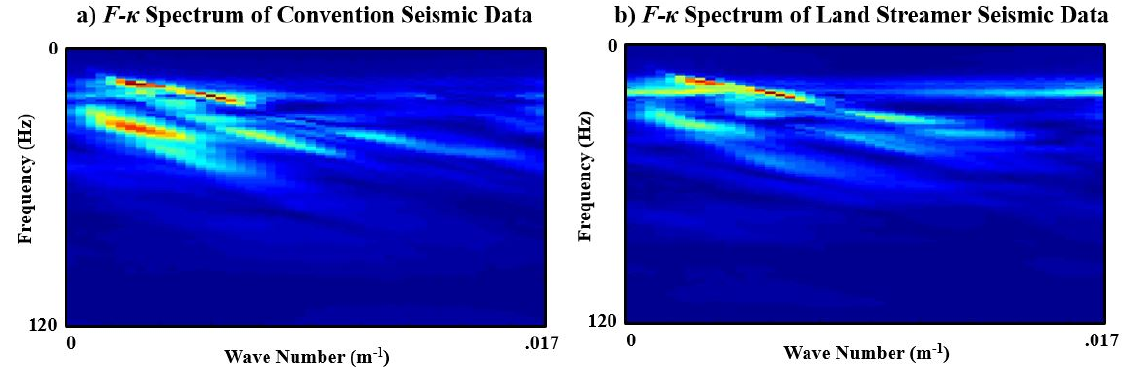
Figure 5. The frequency-wavenumber spectrum of ( a ) conventional and ( b ) land-streamer data sets.